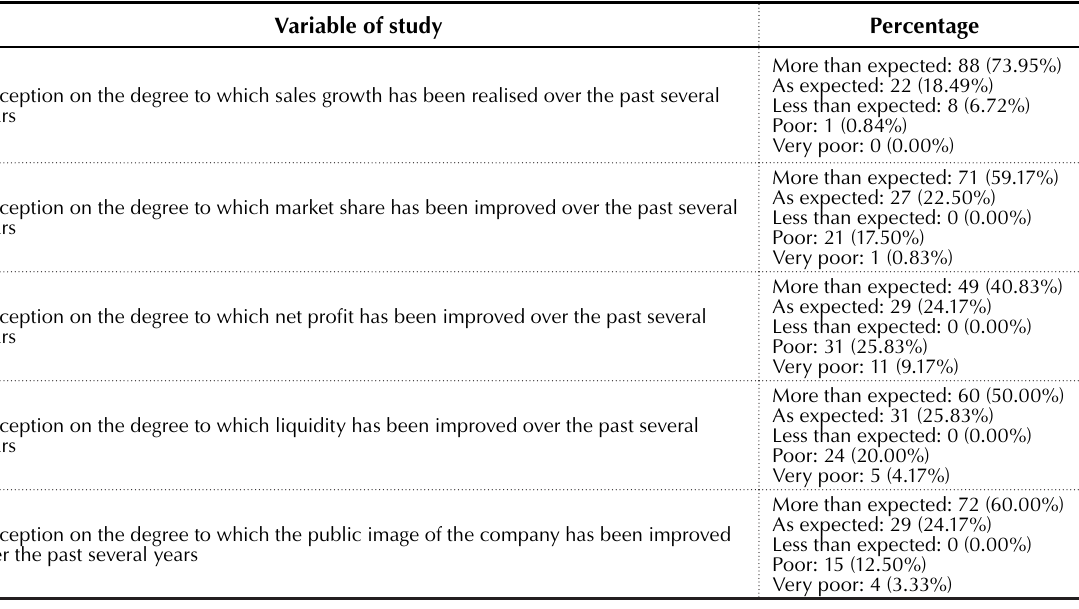
Table 4. Assessment of perception on sales growth and market share (n = 120) Variable of study Percentage